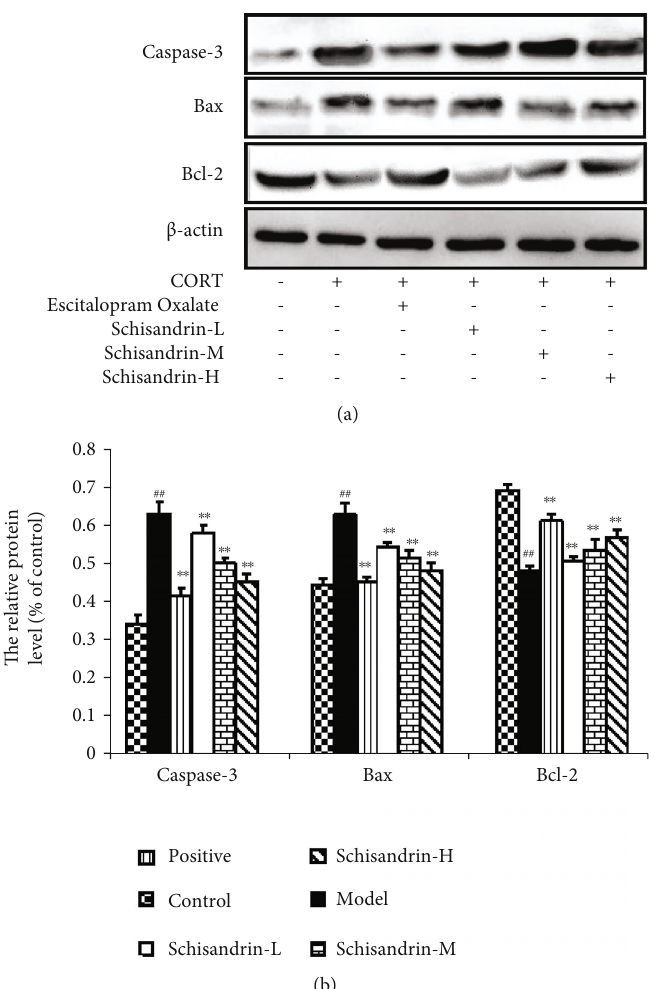
Figure 6: E ff ects of di ff erent concentrations of Schisandrin on CORT-induced Caspase-3, Bax, and Bcl-2 protein expression content in cells. (a) Representative image of immunoblots showing Caspase-3, Bax, and Bcl-2 protein expression. β -actin was used as a loading control. (b) Quanti fi cation of Caspase-3, Bax, and Bcl-2 protein expression. Cells were induced with CORT (250 μ mol/L) for 24 h and subsequently treated with Schisandrin (0.1, 1, and 10 μ mol/L) or CORT (250 μ mol/L) for 24 h. ## p < 0 : 01 , compared with the control group; ∗∗ p < 0 : 01 , compared with the model group. Cell protein expression was detected with western blot